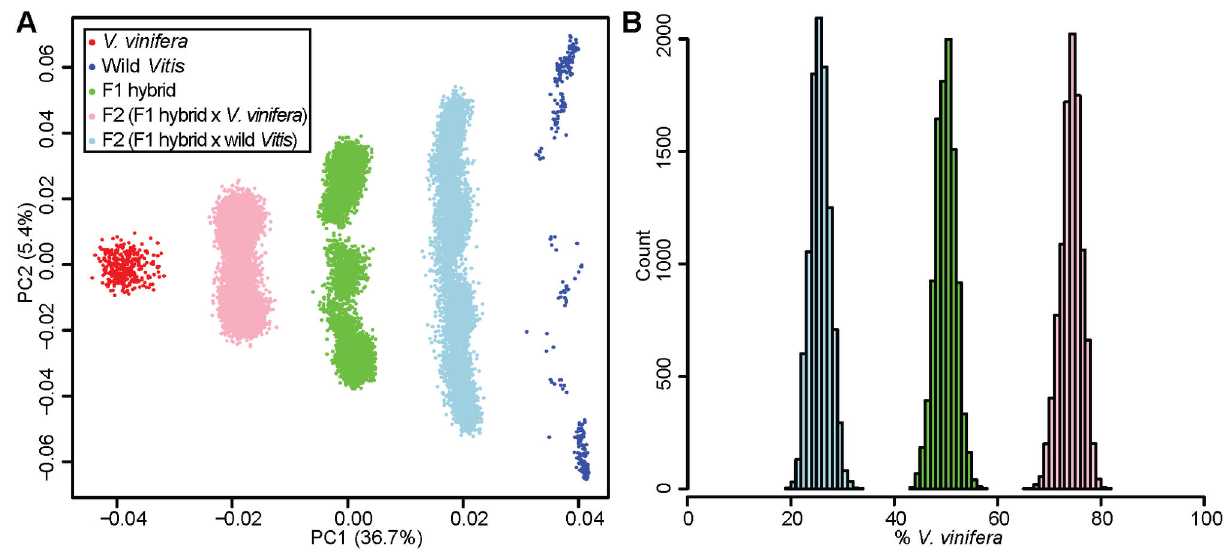
Figure 2. Verification of PCA-based ancestry estimates through simulation. (A) 10,000 F1 hybrids (green) were generated by simulating V. vinifera x wild Vitis crosses. Using the simulated genotype data, these hybrid samples were then projected onto the PC axes defined by the 333 V. vinifera (red) and 333 wild Vitis samples (blue) and the proportion of each F1 hybrid’s ancestry derived from each ancestral population was estimated using our PCA-based approach. The same method was applied to F2 populations derived from backcrossing F1 hybrids to V. vinifera (pink) and backcrossing F1 hybrids to wild Vitis (light blue). (B) The distribution of V. vinifera ancestry proportions for the F1 and F2